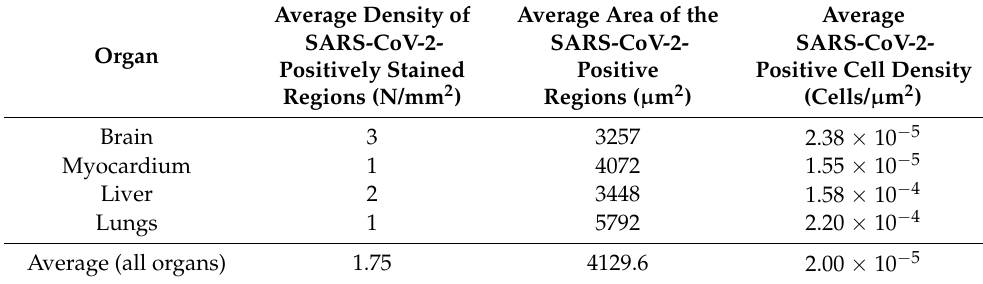
Table 1. Area and enumeration of cells in SARS-CoV2-positive clusters in different fetal organs. Average Density of Average Area of SARS-CoV-2- Organ Positively Stained Regions (N/mm 2 )